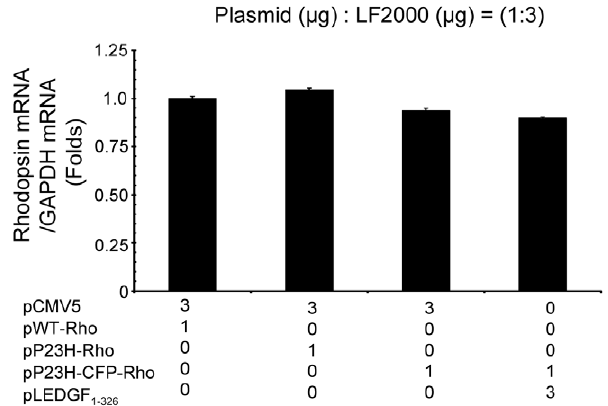
Figure 9. LEDGF 1-326 does not alter the transcription level of P23H rhodopsin. mRNA was isolated from transfected ARPE-19 cells using the RNeasy kit. To remove contaminating genomic DNA, 10 m g RNA from each sample was treated with DNase using the Turbo DNA free kit. First strand synthesis was done using the high capacity RNA to DNA. PCR was performed to amplify the DNA on an ABI 7500 PCR machine. The threshold thermal cycle was used to calculate the mRNA level of rhodopsin and was normalized to GAPDH mRNA level. Data is expressed as mean 6 S.D. for N=3. Data was considered significant at p , 0.01 compared with pWT-Rho transfected